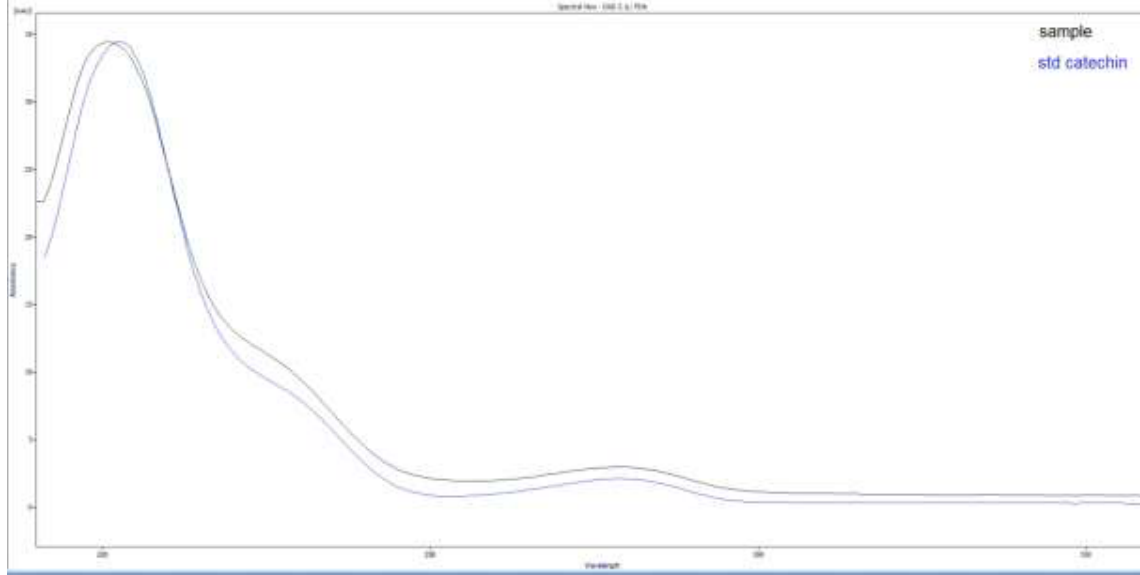
Figure 3. UV spectrum of ethyl acetate fraction matched with standard UV spectrum of catechin.